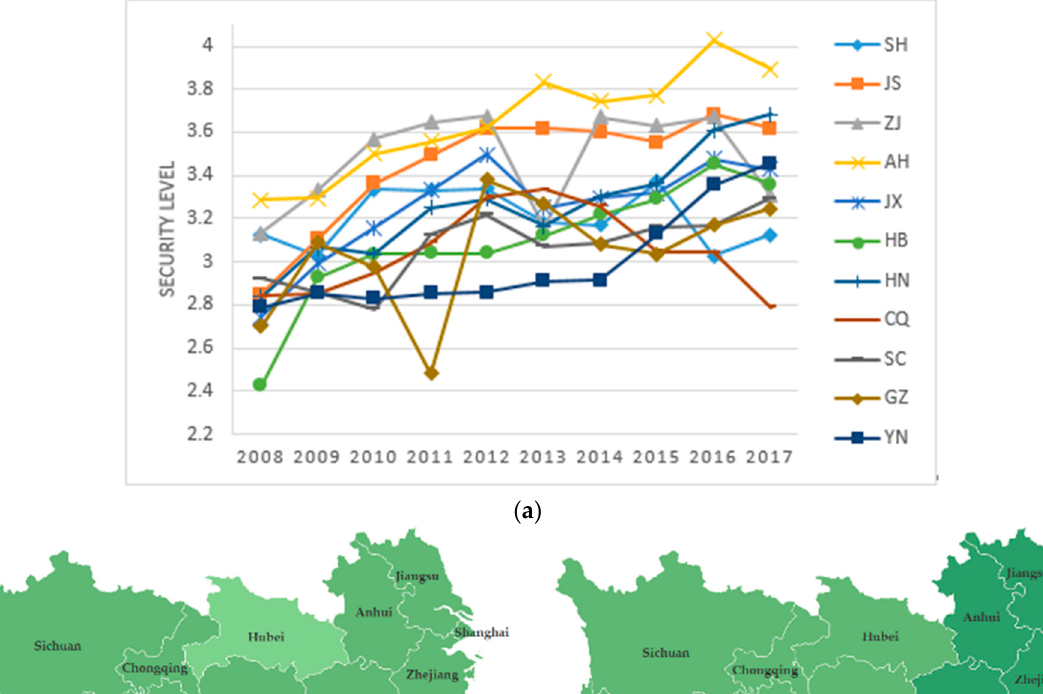
14 of 20 Figure 6. Energy subsystem evaluation results: ( a ) Trend graph of energy subsystem security of each province (munici- pality) in the Yangtze River Economic Belt during 2008–2017; ( b ) Distribution of energy security in 2008; ( c ) Distribution of energy security in 2012; ( d ) Distribution of energy security in 2016. 3. Evaluation of the food subsystem The security level of the food subsystem in the provinces (municipalities) of the Yang- tze River Economic Belt is on the rise, with provinces continuously increasing their invest- ment in agriculture. The disaster control and production technology have also been sig- nificantly improved. The four downstream provinces have a higher level of food security among the 11 provinces, while the four upstream provinces are lagging behind. However, the development trend of Sichuan, Guizhou and Yunnan is fast in recent years. The ad- vantages of economy and technology in the lower reaches of the Yangtze River have ef- fectively ensured food security, with advanced agricultural production technology, com- plete power machinery supporting facilities and a better consumption structure than those in the middle and lower reaches. The middle reaches are vulnerable to flood disas- ters, which affects food production. In recent years, the disaster prevention and manage- ment in this area have been significantly improved, and food security has been raised. The security level of Hunan Province reached Level 4 in 2016, and Hubei and Jiangxi are also